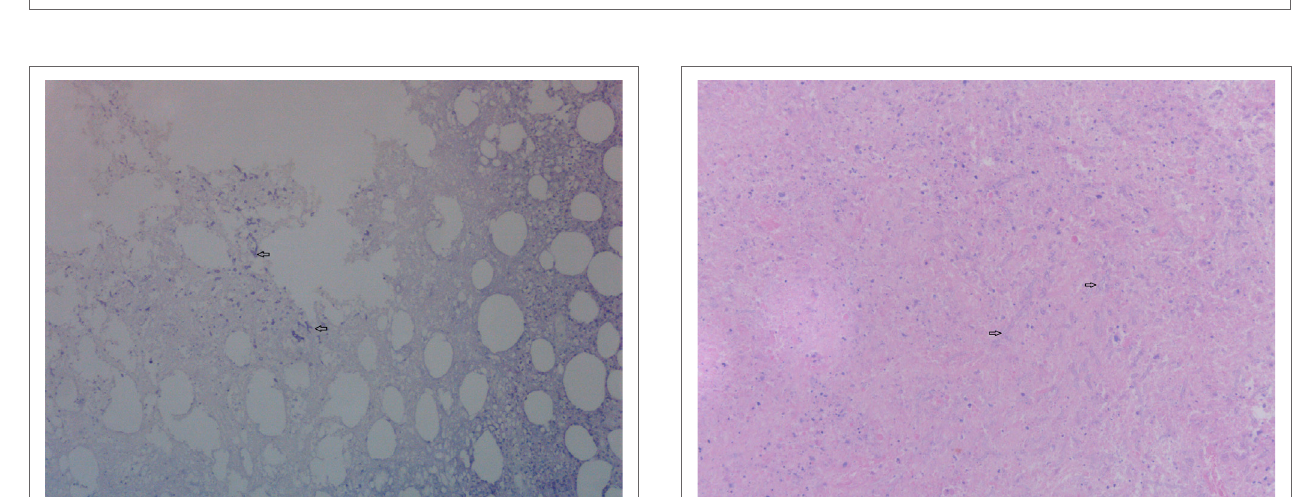
FIGURe 4 | Brain magnetic resonance imaging in May 2014. There is an increase in size of the right frontal lesion with surrounding perilesional edema. T2-weighted image (left) demonstrates a hypo-intense rim with ring-enhancement after gadolinium (contrast-enhanced T1-weighted middle). At diffusion imaging (right panels) there is restricted diffusion in a part of the central area.